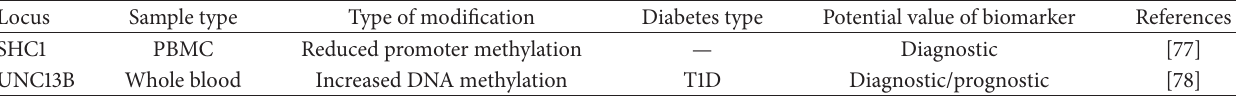
Table 4: Epigenetic markers. List of epigenetic marks identified in DN. List is ordered